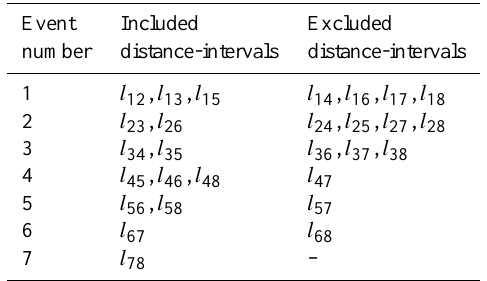
Fig. 3. An illustration of directed, spatio-temporal recurrence graph of a sample earthquake catalogue. Eight events shown here are in 2-D space and are labeled according to their order of occurrence in time. Arrows denote the network of recurrences. Table 1. Record-breaking distance-interval ( l ij ) recurrences of time-ordered events. We chose eight events, as shown in Fig. 3, to illustrate the selection of record-breaking